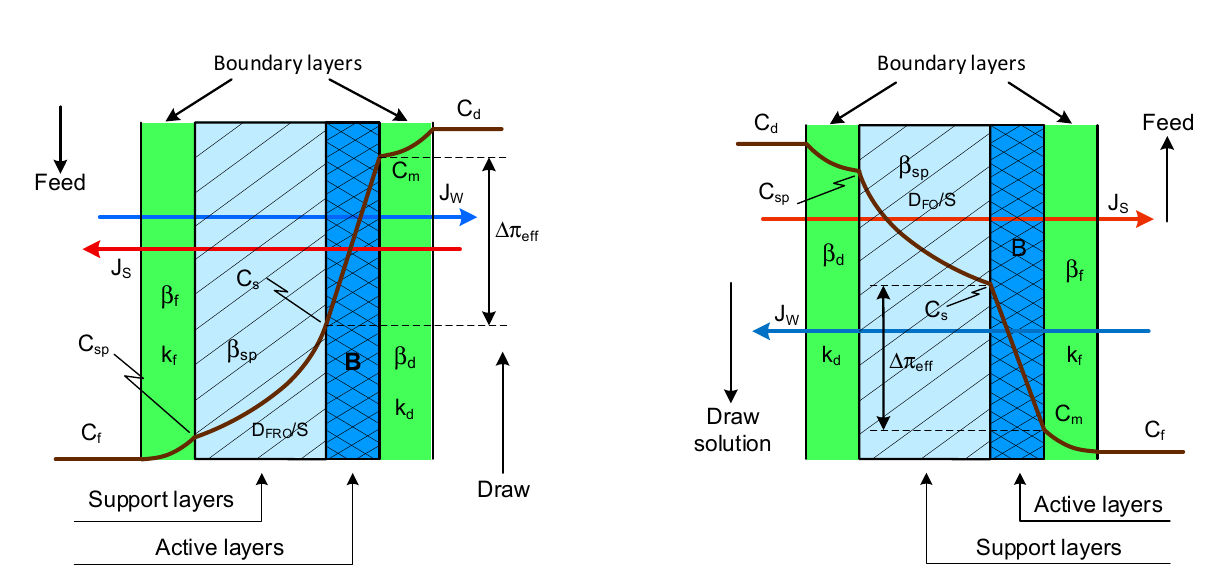
Figure A1. Illustration of the concentration distribution and nomenclature of parameters for PRO (left-hand side figure) and FO (figure on the right-hand side) processes, including external mass transfer resistances. C m and C s correspond to the interface concentration of the active layer facing the boundary layer and facing the porous support layer, respectively. Δπ eff is the effective osmotic pressure difference on the active layer.